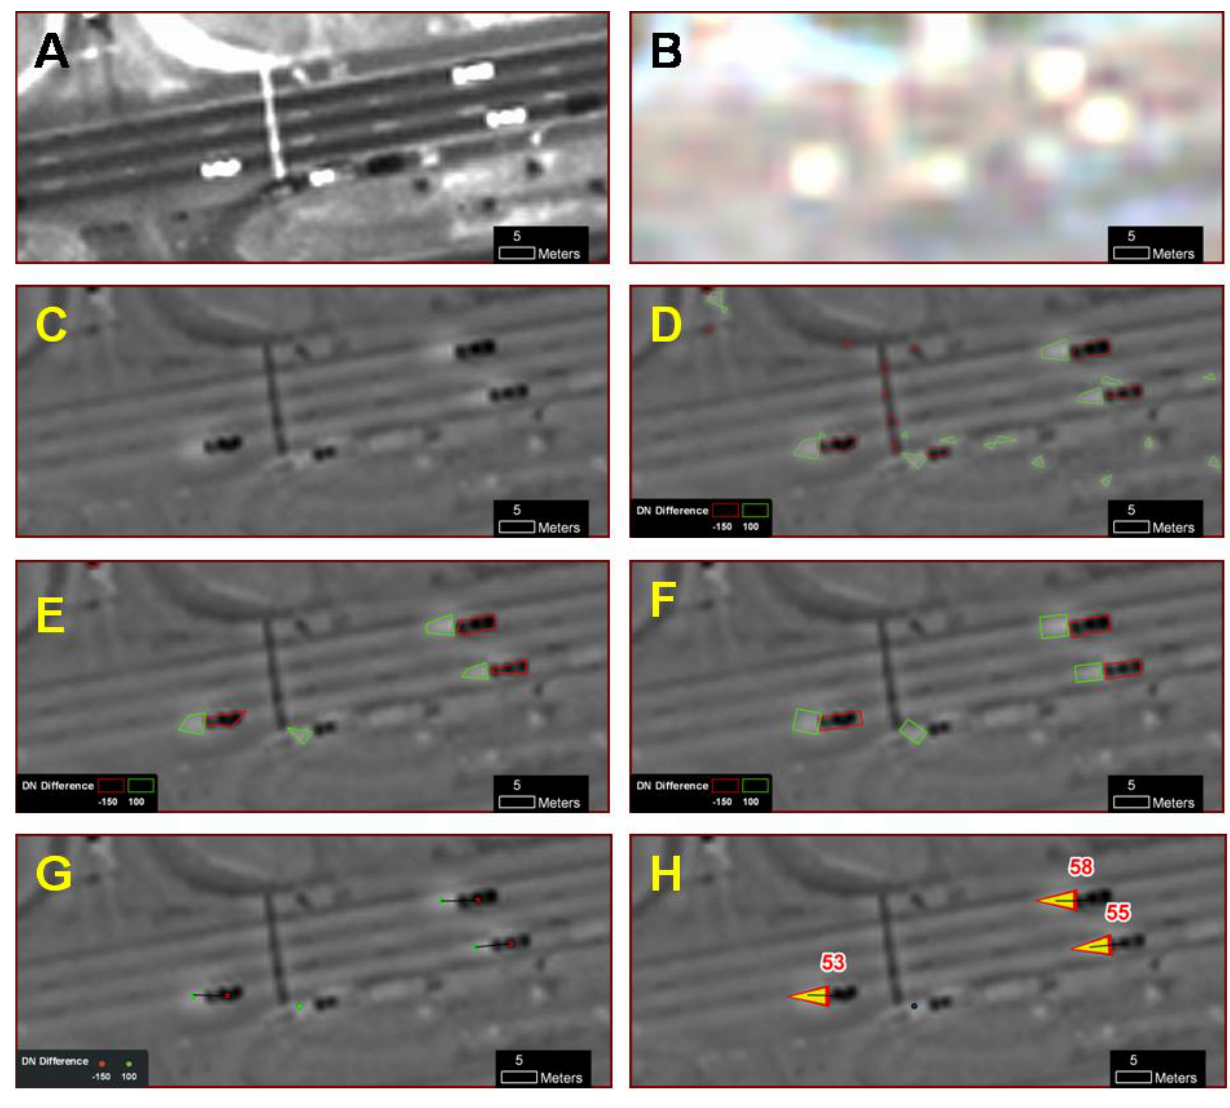
Figure 2. A panchromatic (a) and multispectral (b) segment of a road is subjected to image subtraction (c) . Raster cells are converted to polygons representing initial and final locations (d) and then sieved by area (e) . Bounding boxes used for sieving by elongation (f) to counter parallax and pixel mixing. The centroid of these polygons are paired for the movement vector (g) to determine the Dynamic Offset of Target for estimated speed in miles per hour (h)